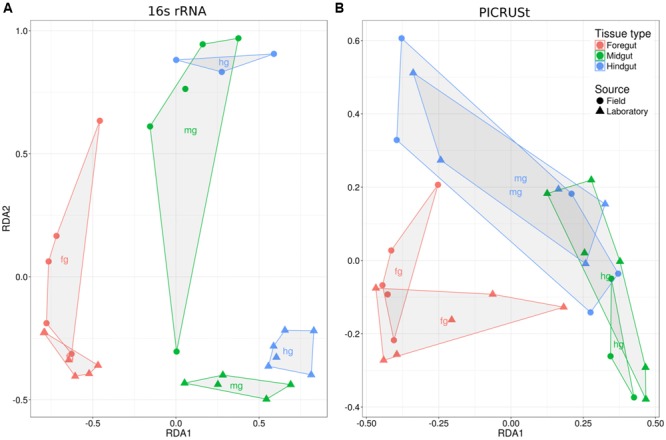
Ordination of sample scores from the db-RDA of the reduced dataset for (A) Illumina 16S rRNA sequencing and (B) PICRUSt metagenomic predictions. Note that field-caught and laboratory-raised animals differ in the DNA extraction method that was used.